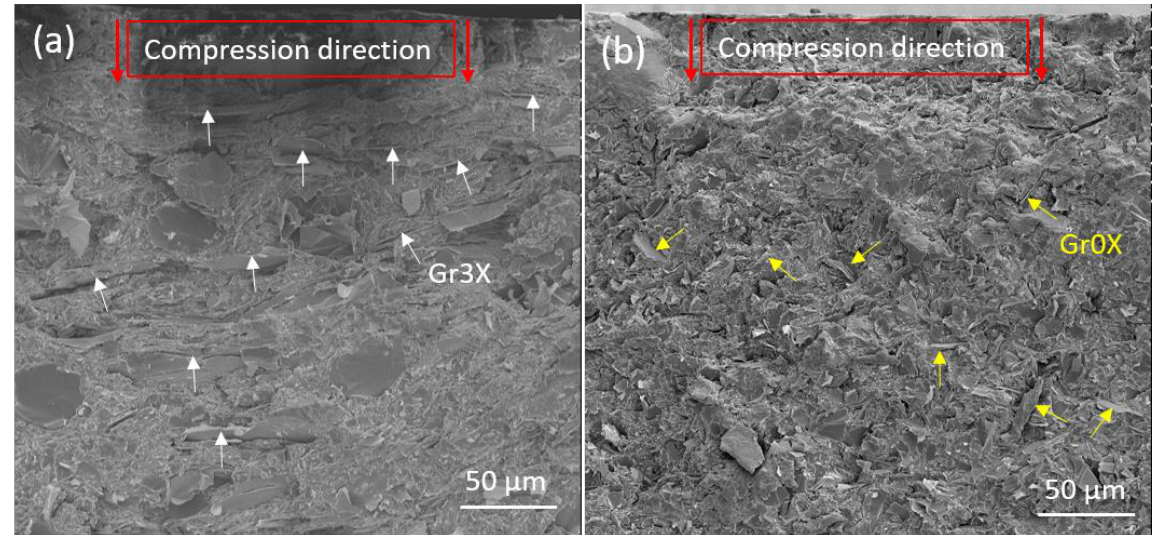
Figure 4. SEM images of the areas close to the top surface of the hot-pressed GnP/polyester composites containing ( a ) 25 wt.% Gr3x versus ( b ) 25 wt.% Gr0x.